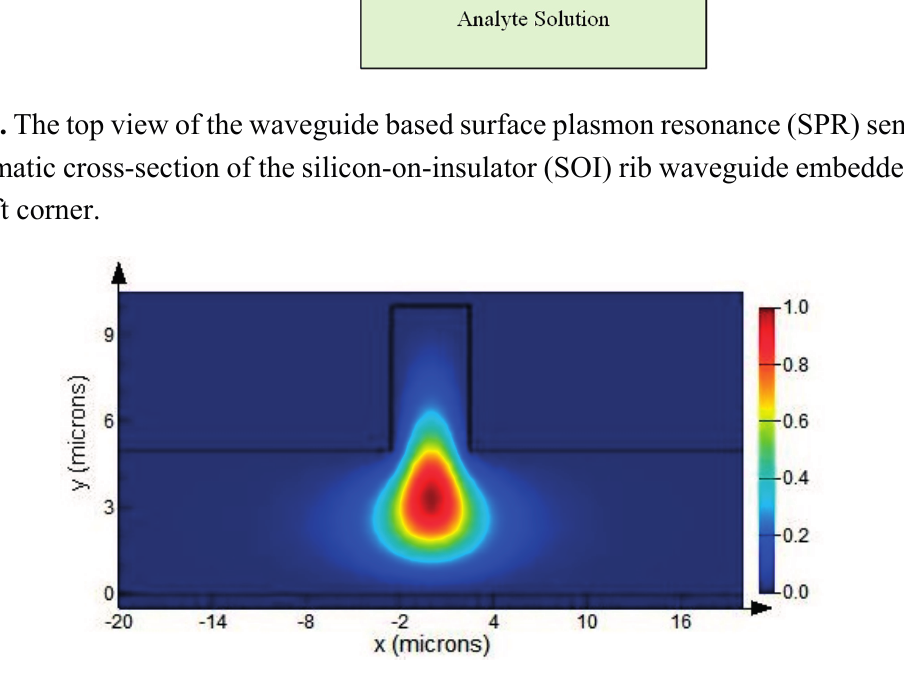
Figure 2. The mode distribution of the SOI rib waveguide with H = 10 μ m, h = 5 μ m and w = 5 μ m at an operating wavelength of 1550